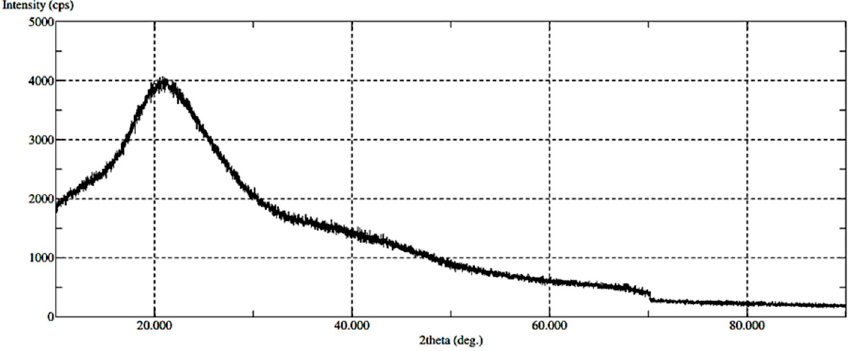
Figure 6. XRD results of the produced CHT_Fe@Au_POX-SH particles.